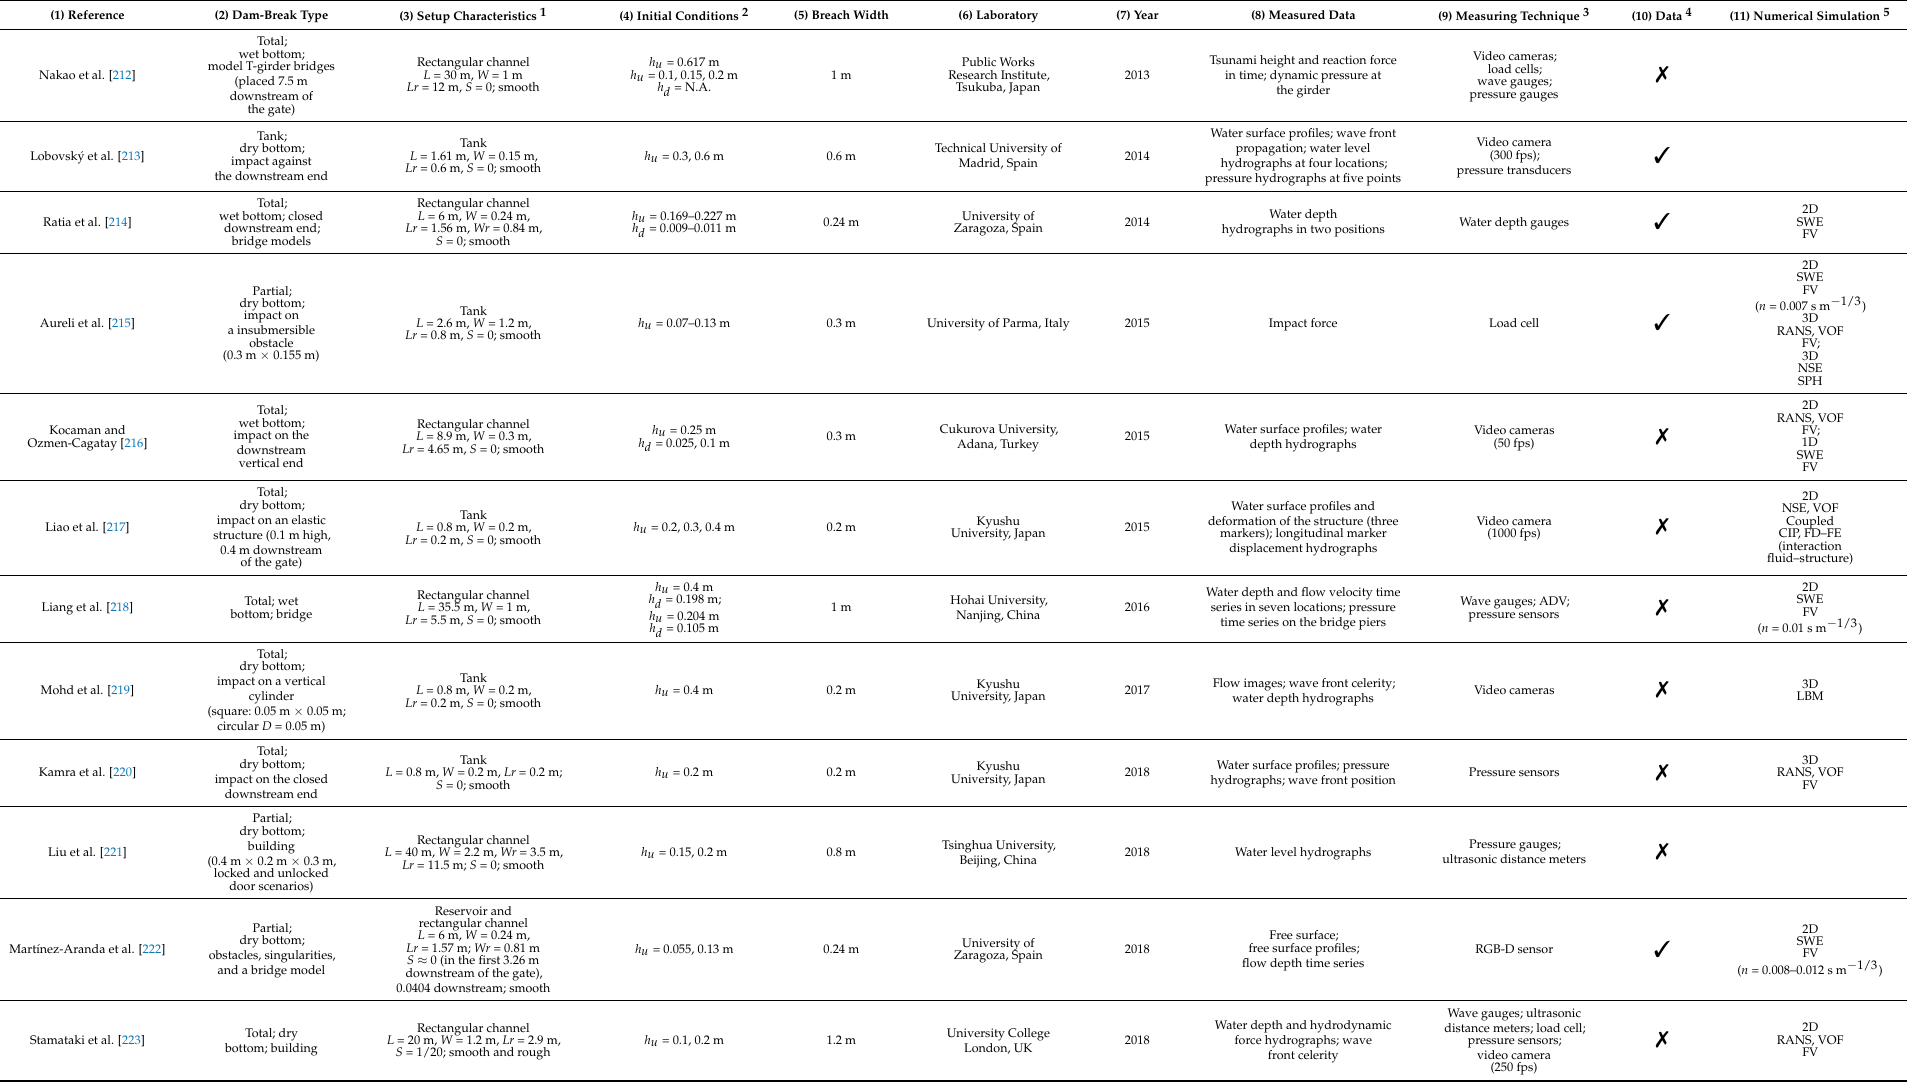
Table 1. Basic experimental investigations of fundamental dam-break wave physical characteristics.